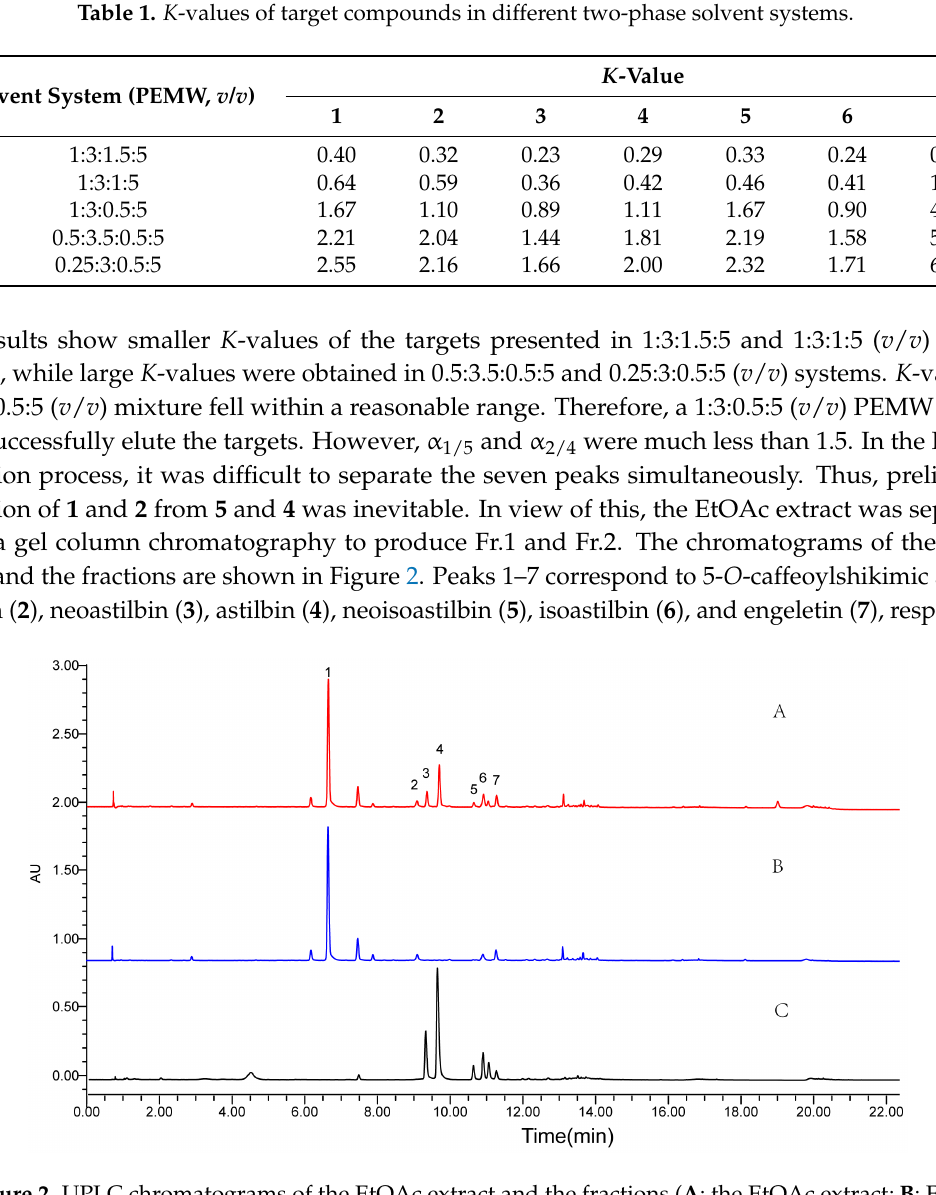
Figure 2. UPLC chromatograms of the EtOAc extract and the fractions ( A : the EtOAc extract; B : Fr.1; C : Fr.2) Experimental conditions: an ACQUITY UPLC T3 column (100 mm × 2.1 mm i.d., 1.8 μ m).